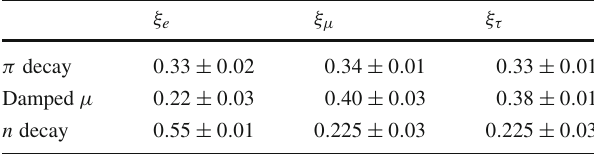
Table 1 Flavor composition expected at Earth for the three different